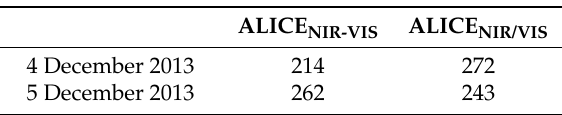
Table 2. Number of anomalous pixels identified by the two ALICE indices in the two analyzed VIIRS imagery.